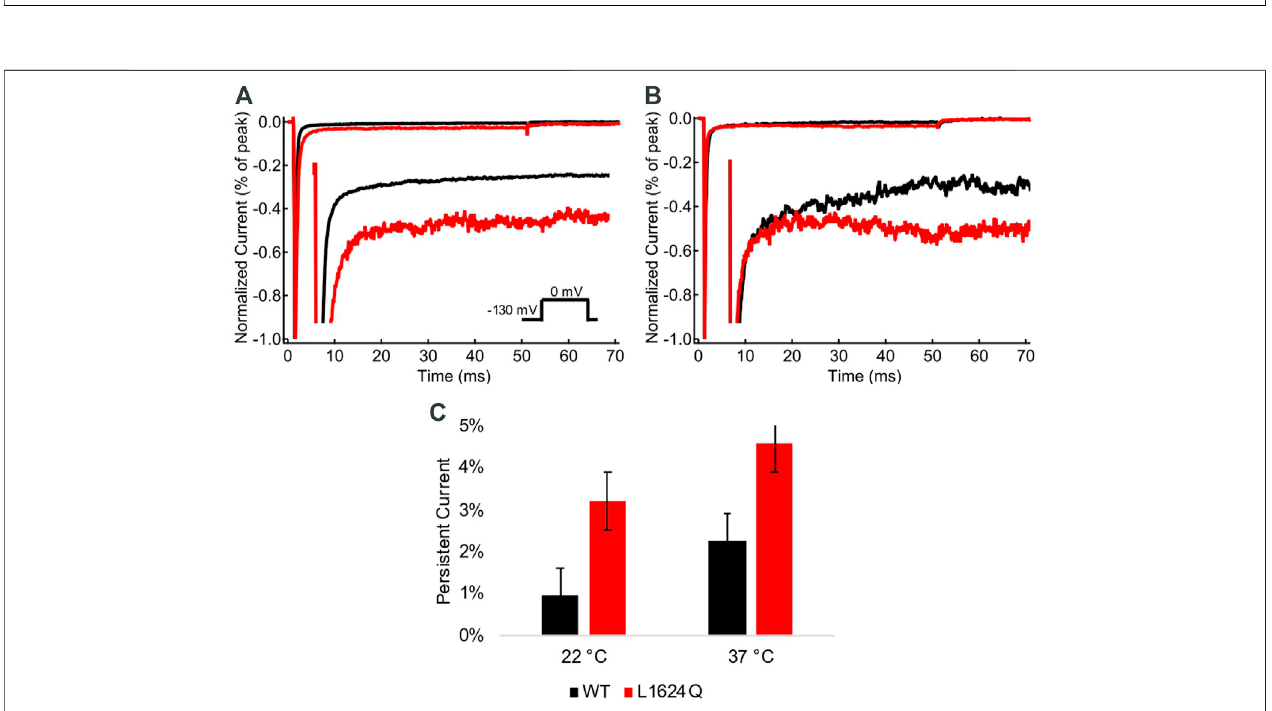
FIGURE4| L1624Qincreasespersistentcurrent. (A,B) :Representativenormalizedcurrenttracesfromwildtype(black)andL1624Q(red)channelsat22 ° C (A) and 37 ° C (B) . Insets : Zoomed in view of the non-inactivating currents. (C) : Bar chart comparing the fraction of persistent current in WT (black) and L1624Q (red) channels at 22 ° C (n WT (cid:1) 5, n LQ (cid:1) 4) and 37 ° C (n WT (cid:1) 4, n LQ (cid:1) 5). All midpoint measurements are mean and error bars represent standard error of the mean.